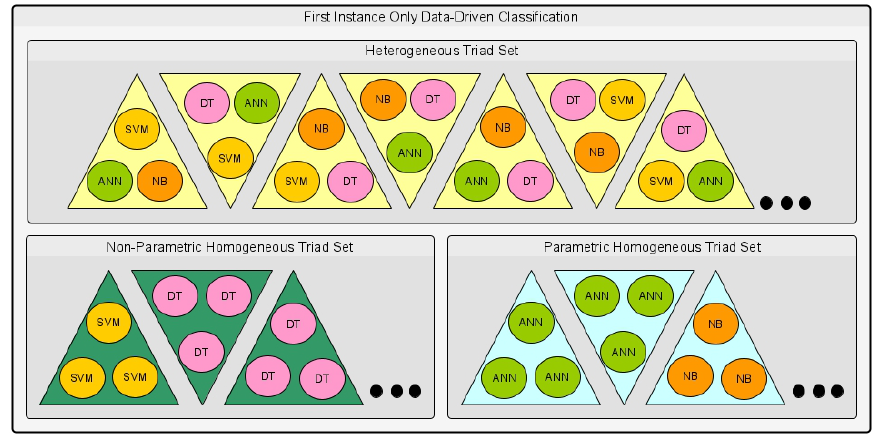
Figure 3. Ensemble triads general concept.